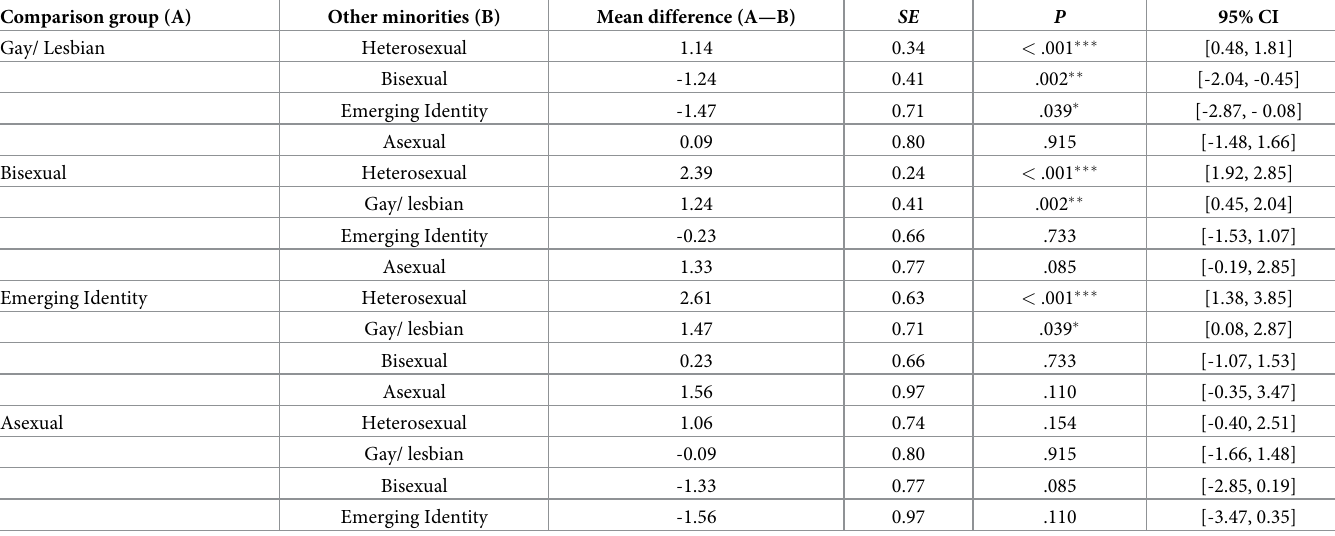
Table 5. Comparisons of anxiety symptom scores by sexual orientation. Comparison group